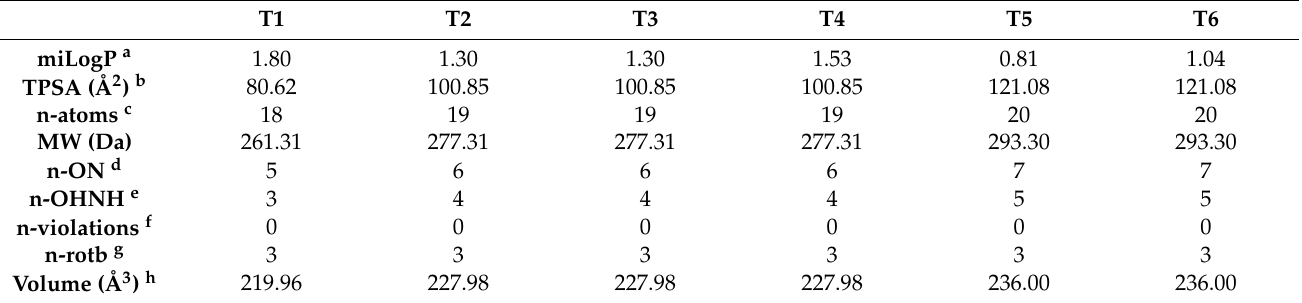
Table 3. Calculated molecular descriptors for the studied